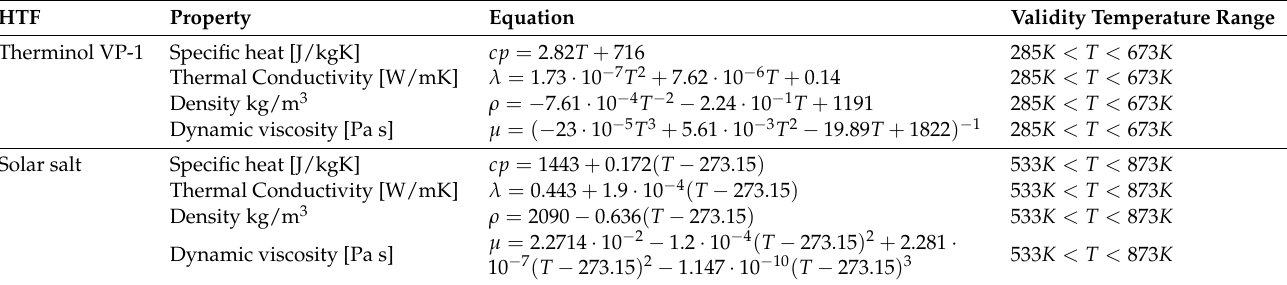
Table 4. Correlations of HTFs’ thermophysical properties as a function of temperature